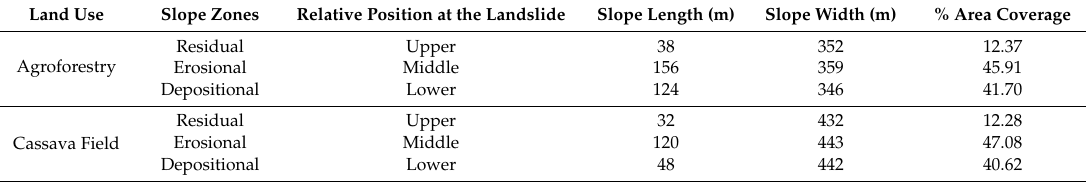
Table 1. Zones of the Slope Units that Formerly Experienced